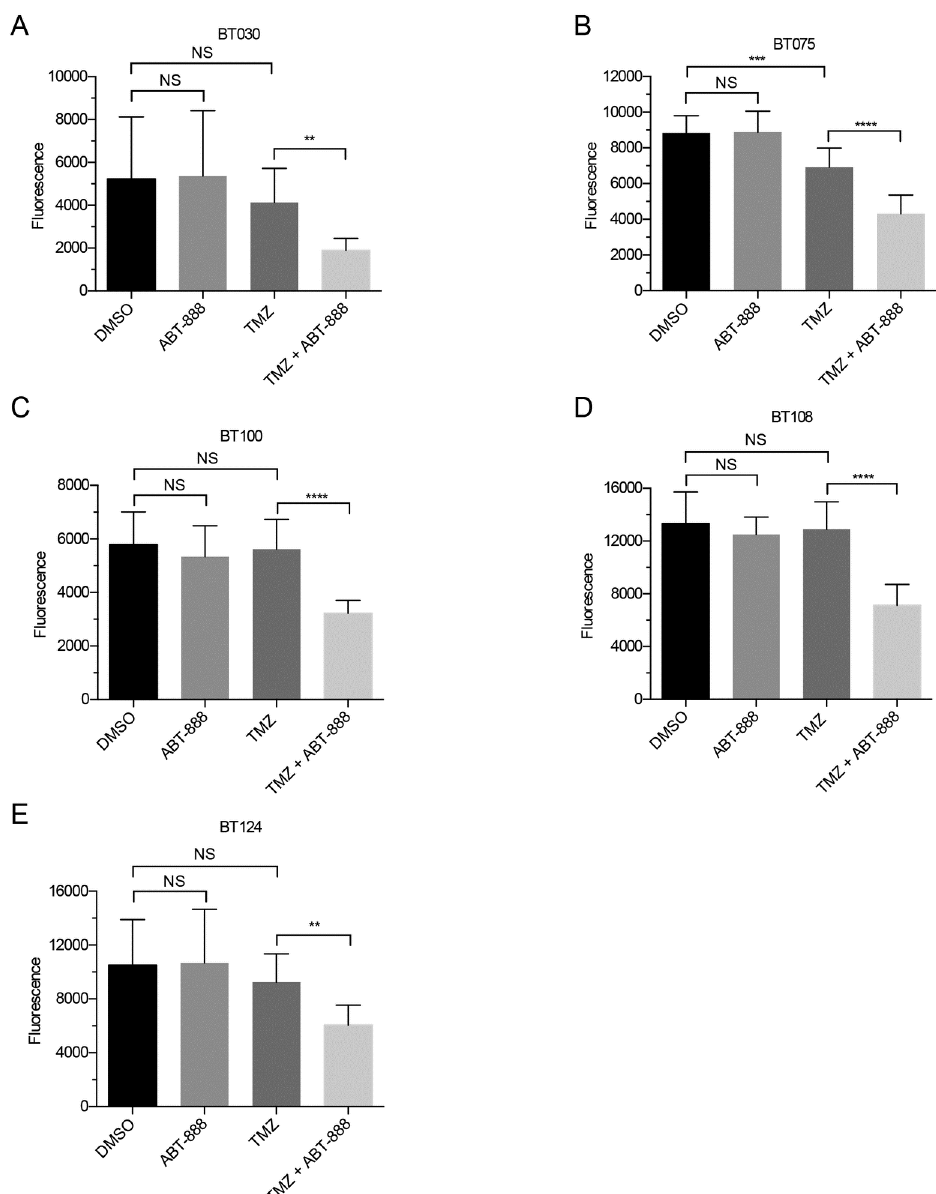
Fig 2. Average viability of Group II BTICs (n = 3, ± SD). Assessments and statistics were performed as in Fig 1. Viability was unaffected by ABT-888 or TMZ alone, except for BT075 (B). The combination of TMZ and ABT-888 significantly decreased viability in all BTICs (ns = p > 0.05; (cid:3)(cid:3) = p < 0.01; (cid:3)(cid:3)(cid:3) = p < 0.001; (cid:3)(cid:3)(cid:3)(cid:3) = p <